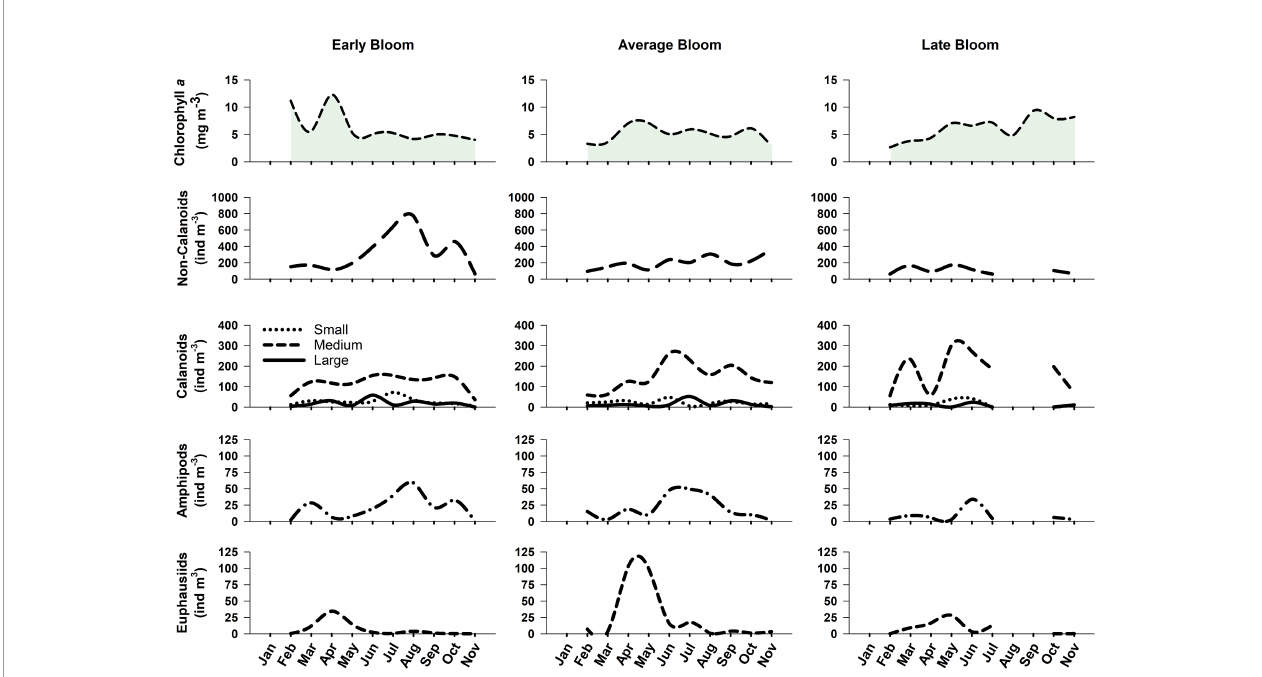
FIGURE 6 | Total abundance (ind m -3 ) for non-calanoid and calanoid copepods, hyperiid amphipods, and euphausiids during early (2004, 2005, 2015; left panels), average (2003, 2006, 2009-2014, 2016; middle panels), and late (2007, 2008; right panels) Chl a bloom years in the Central Strait of Georgia,